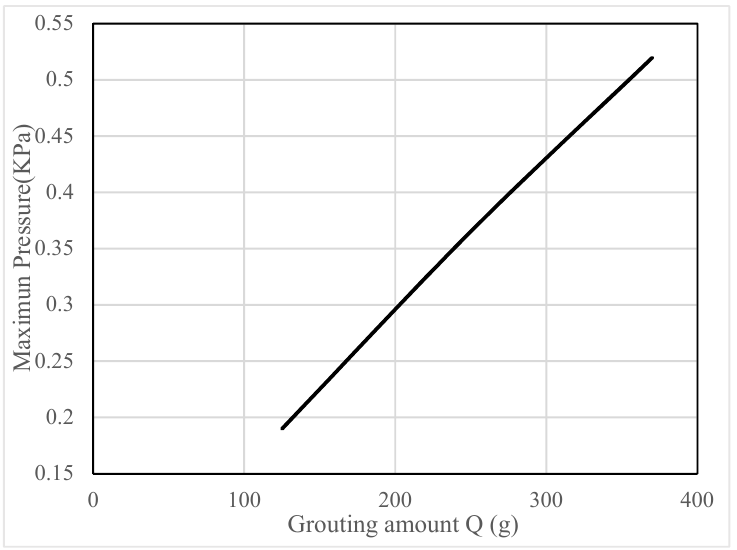
Figure 11. Relation curve between maximum pressure and grouting volume.